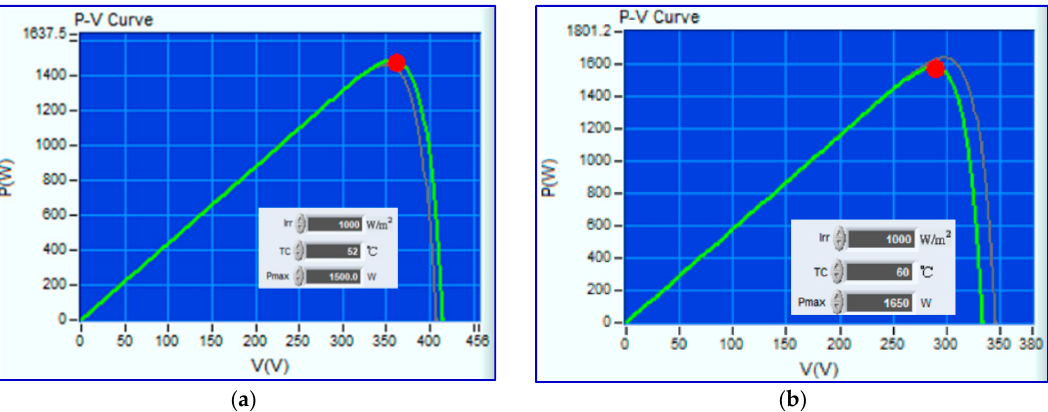
Figure 14. Experimental P–V tracking curve results of the constant irradiation and change temperature. ( a ) 1000 W/m 2 , 52 °C ( b ) 1000 W/m 2 , 60 °C.